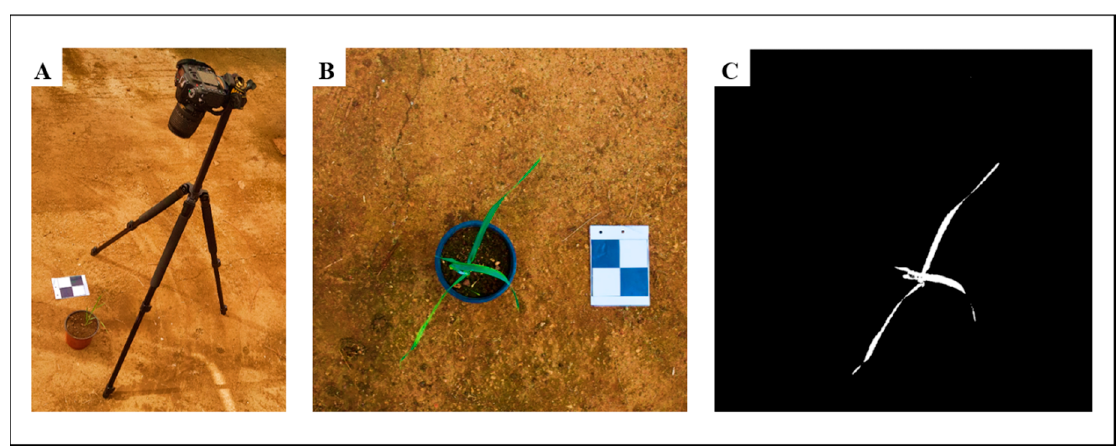
Figure 1. ( A ) Imaging setup of the 2-D phenotyping method. ( B ) A blowup image of the triticale plant and ( C ) the extracted projected shoot area (PSA).